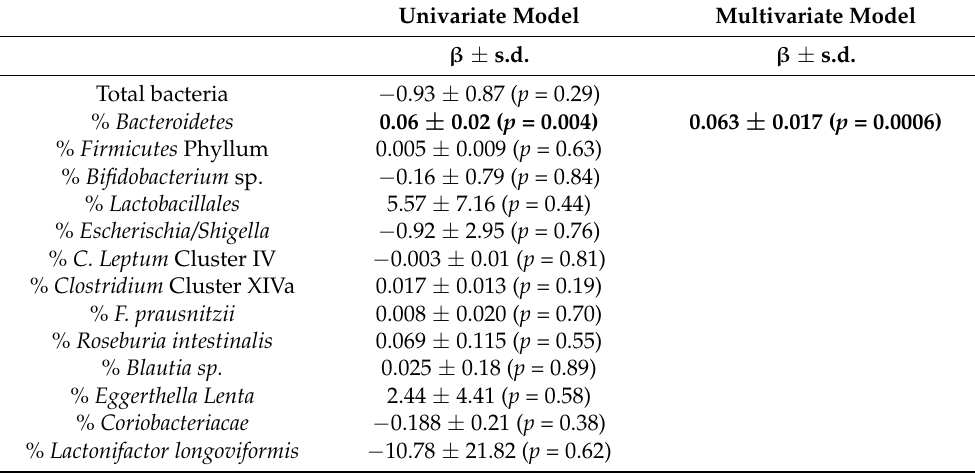
Table 5. Relationship between apo AIV gene expression in Caco-2 cells exposed to FW from the whole studied population and short chain fatty acids in FW or abundance of given bacterial genes in stools. Univariate Model Multivariate Model β ±